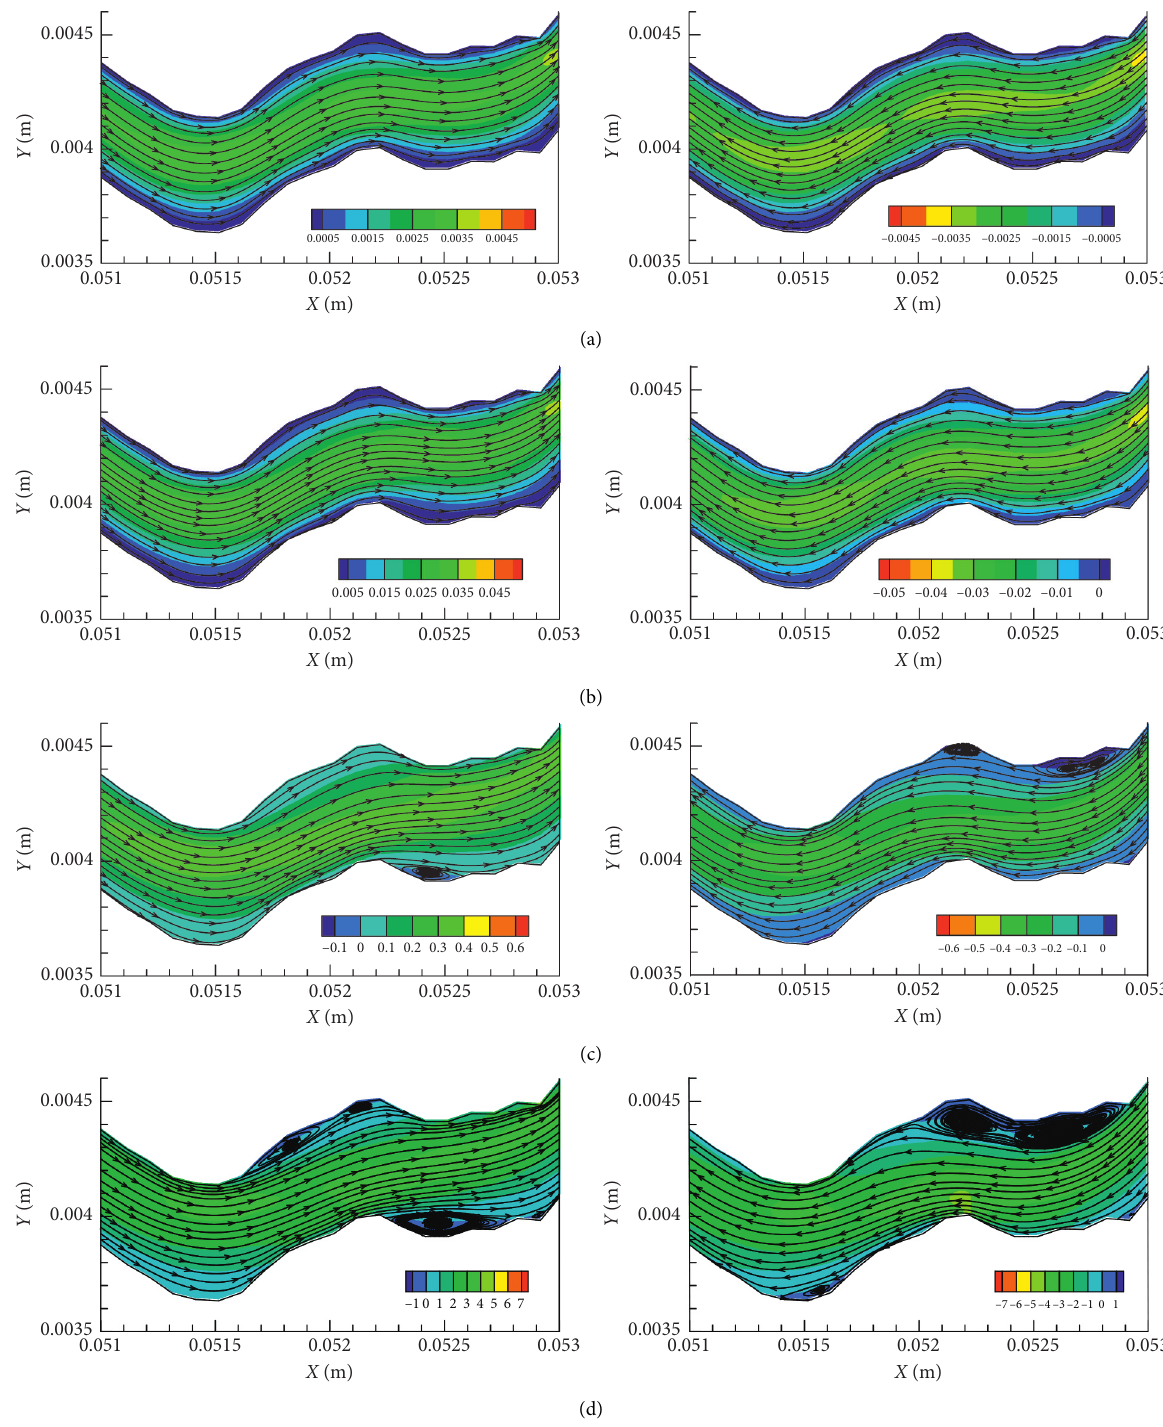
Figure 8: X -direction velocity contour and flow line of the original profile model under different Reynolds numbers in the forward and reverse directions (the contour represents the velocity distribution, m/s). (a) Re � 1. (b) Re � 10. (c) Re � 100. (d) Re �